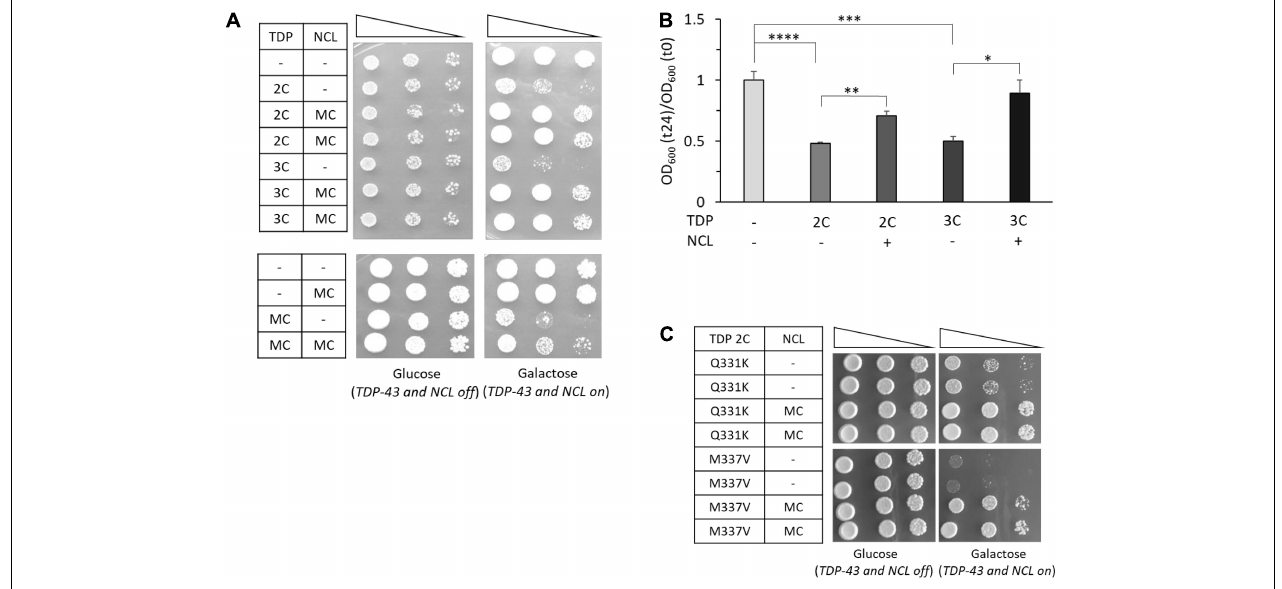
FIGURE 3 | Overexpression of human NCL antagonizes the toxicity of WT and mutated TDP-43 in yeast cells. (A) Yeast CENPK cells carrying two (2C) or three (3C) genomic copies of TDP-43 transgene (upper panel) or containing TDP-43 multi-copy plasmid (MC) (lower panel), were transformed to co-express the human NCL protein by galactose-inducible vectors (MC). Yeast cells (OD 600 = 1) of each strain were serially diluted (10-fold) and spotted onto either inducing medium plates (galactose, TDP-43/NCL on), or repressing condition as control (glucose, TDP-43/NCL off), and incubated at 30 ◦ C for 5 days (3 days for glucose plates of the upper panel). Data are representative of 3 experiments yielding comparable results. (B) The growth rate of the yeast strains of (A) was quantitatively determined as previously described (see Figure 1B ). n = 9 for each strain. ∗∗∗∗ p < 0.0001, ∗∗∗ p < 0.001, ∗∗ p < 0.01, ∗ p < 0.05, Kruskal–Wallis test followed by a Dunn’s post hoc test. (C) Viability assay in yeast strains carrying two genomic copies of mutant TDP-43 (M337V and Q331K) and transformed with NCL multi-copy plasmid (MC), or the empty vector (–) as control, performed as described above. Plates were incubated at 30 ◦ C for 5 days. Data are representative of three experiments yielding comparable